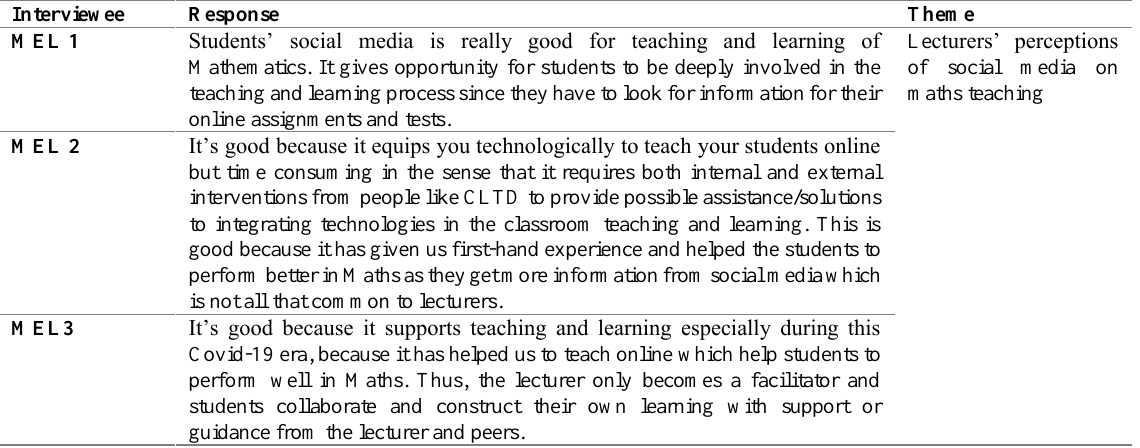
Table 3: Question 3 - What are your perceptions as a lecturer, of the use of social media in the teaching of Mathematics?